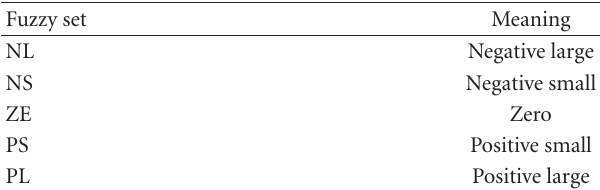
Table 2: Fuzzy sets and output membership